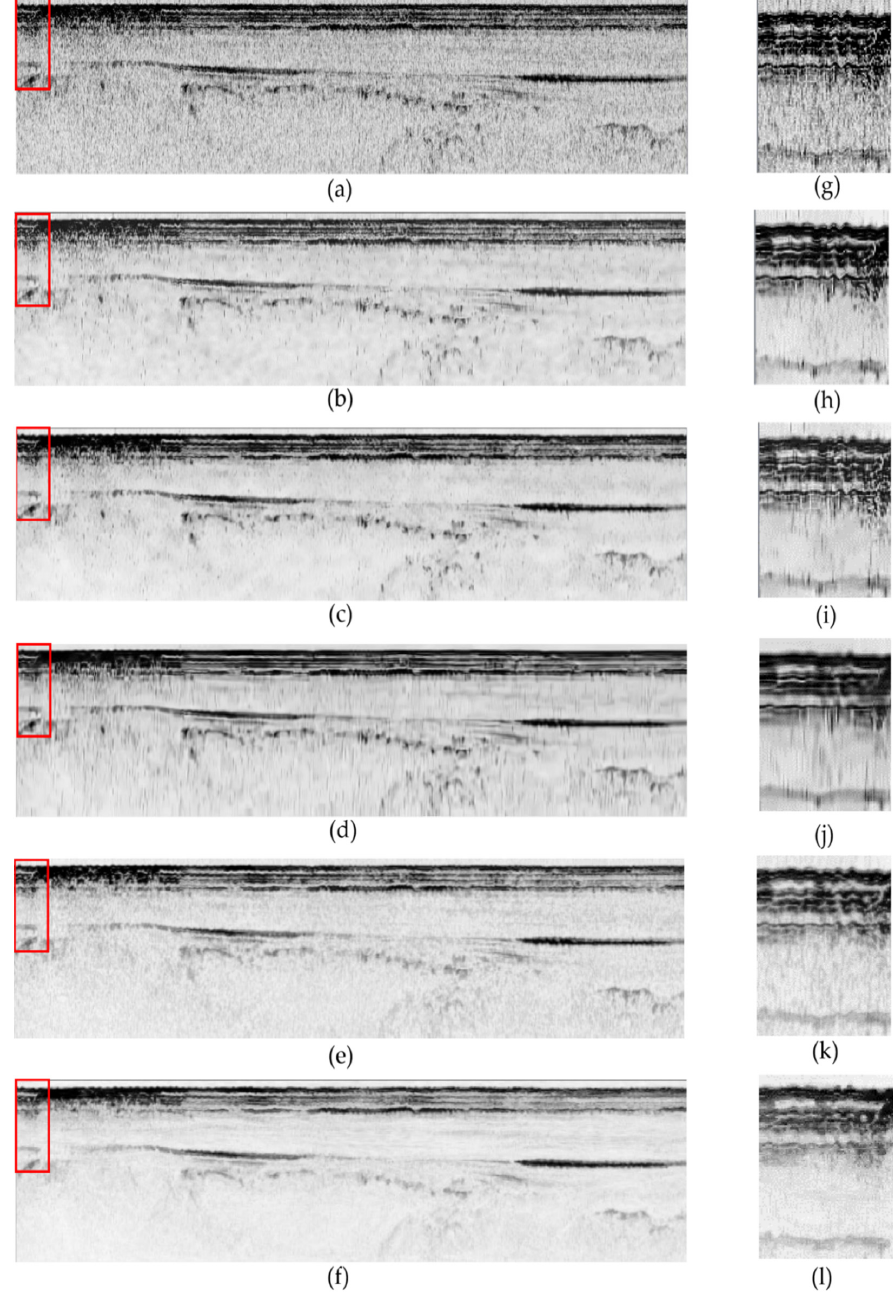
Figure 13. Filtering results: ( a ) is the SBP image, ( b – f ) are the filtered results using KSVD, NLM, BM3D, NLLR, and the proposed method, ( g ) is the details of the SBP image in the rectangle area in Figure 13a, ( h – l ) are the filtered results in the rectangle area in Figure 13a using KSVD, NLM, BM3D, NLLR, and the proposed